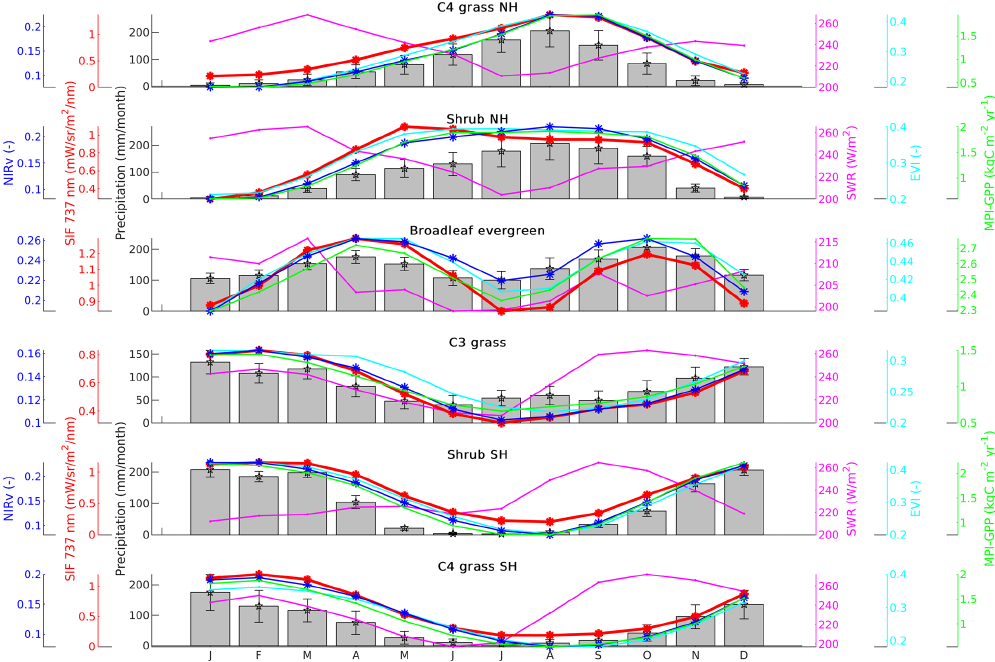
Figure 4. Seasonal cycles of NIRv, SIF, precipitation, shortwave radiation (SWR), the EVI, and MPI GPP at a 0 . 5 ◦ × 0 . 5 ◦ resolution over major biomes of Africa covering the period from 2007 to 2011. The error bars provided for precipitation denote the standard deviation around the